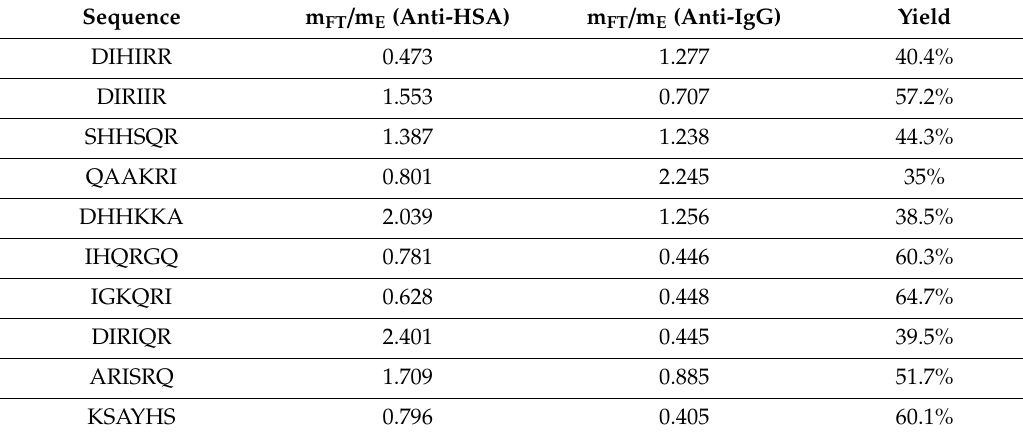
Table 2. Sequence flow-through elution mass ratio for both anti-human serum albumin (HSA)